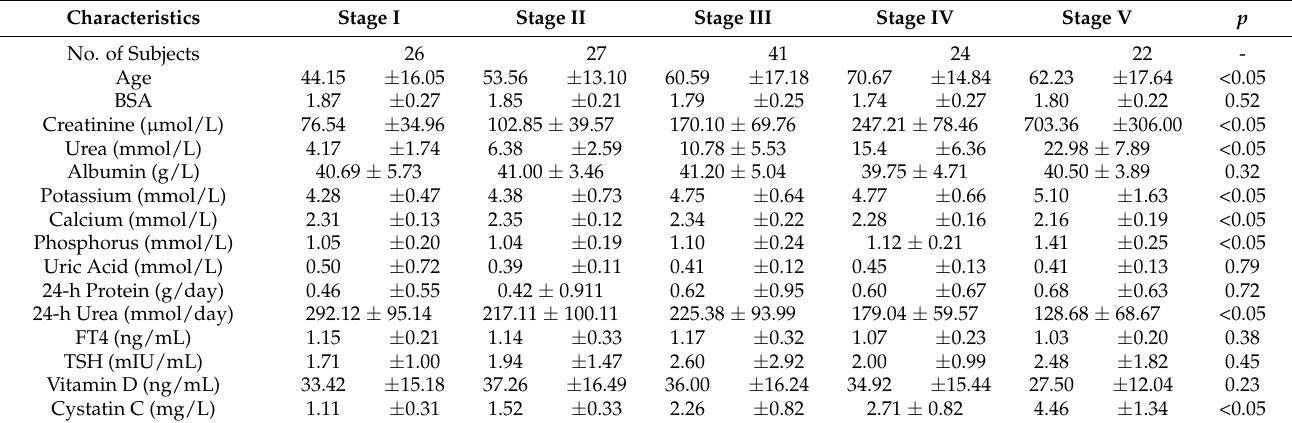
Table 3. Biochemical characteristics of patients at different CKD stages.